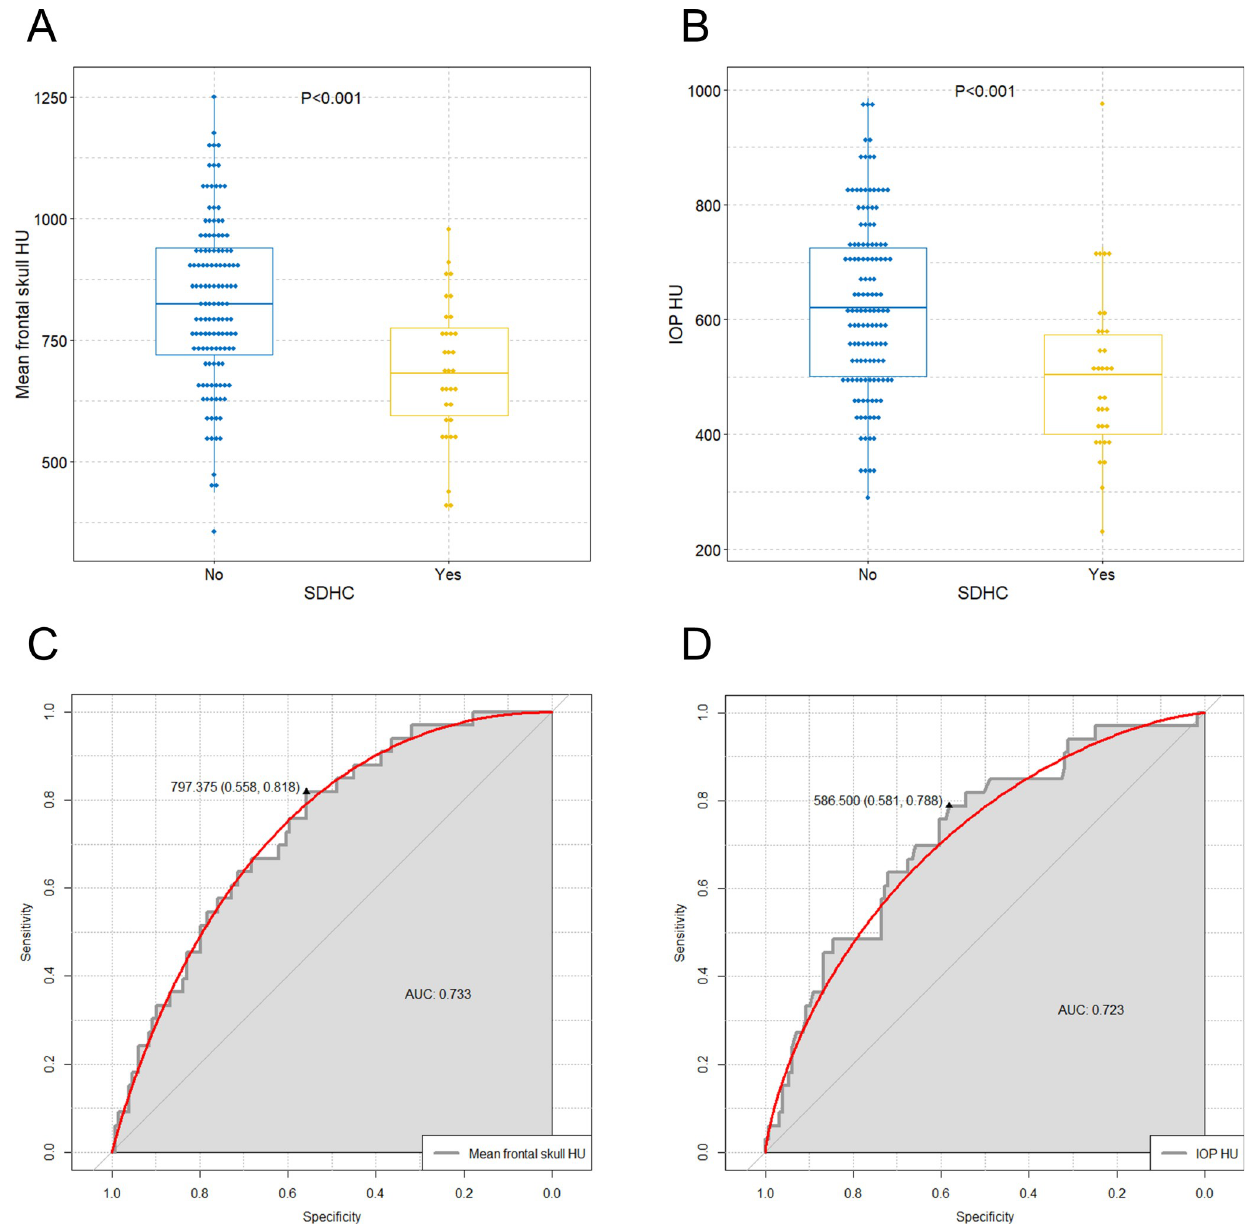
Fig 3. Comparison of mean frontal skull HU and IOP HU values between SDHC and non-SDHC groups and determination of the optimal cut-off skull HU values for prediction of SDHC after DC for traumatic acute SDH. Boxplots with dot plots of (A) mean frontal skull HU values and (B) IOP HU values according to SDHC. ROC curve to identify the optimal cutoff values of (C) mean frontal skull HU values and (D) IOP HU values for prediction of SDHC. HU = Hounsfield unit; IOP = internal occipital protuberance; SDHC = shunt-dependent hydrocephalus; DC = decompressive craniectomy; SDH = subdural hematoma; ROC = receiver operating characteristic; AUC = area under the curve.